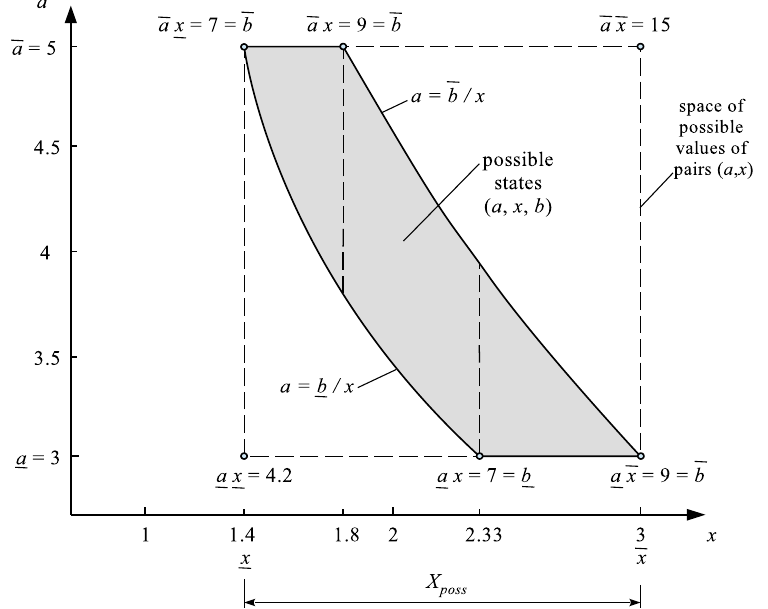
Figure 8. The set S of possible states ( a , b , x ) of the system ax = b , a ∈ [ 3,5 ] , b ∈ [ 7,9 ] , x ∈ [ 1.4,3 ] = X poss , in 2D-space A × X